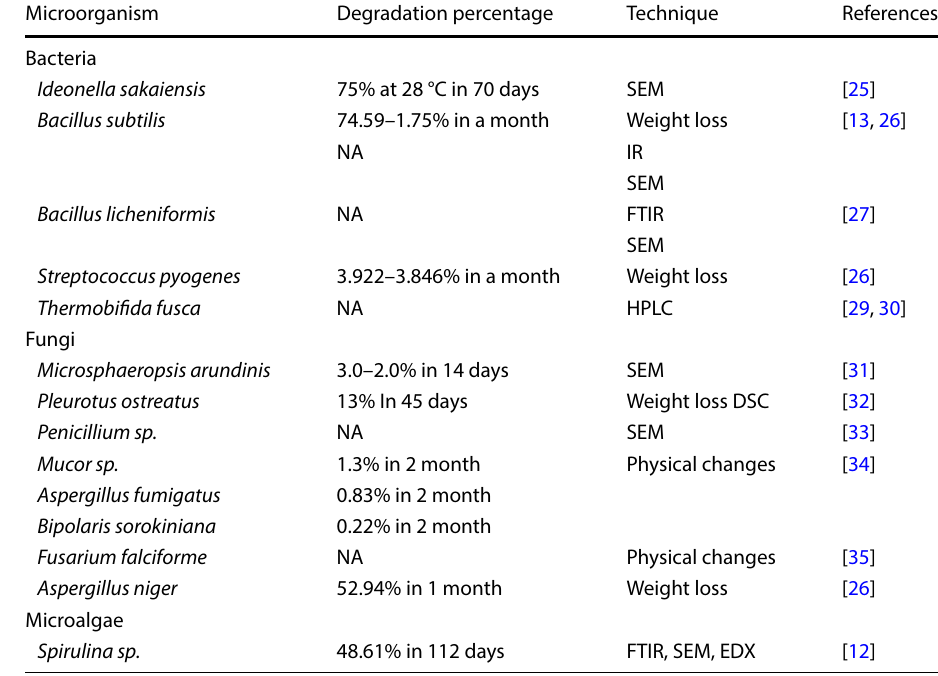
Table 1 Wild-type microorganisms with the ability to degrade PET, publications made in 2015 and